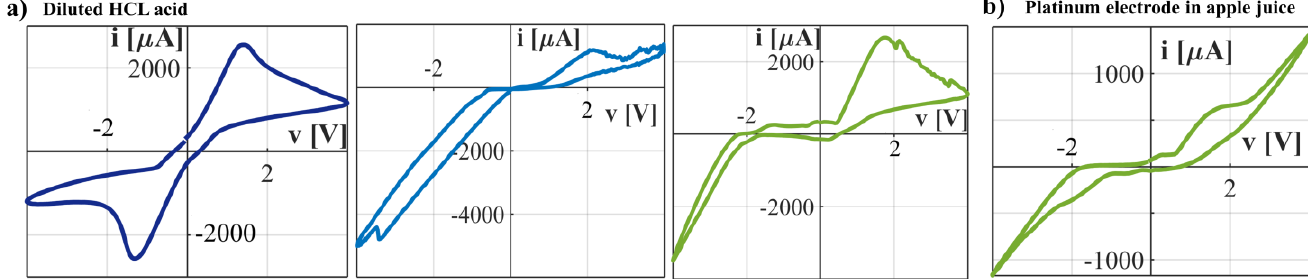
Fig. S3: Additional voltage current plots, always shown for the second period of each measurement. These extra measurements were done in December 2019 with a sinusoidal voltage with an amplitude of 4 V and a frequency of 0.005 Hz. Results from the silver/silver chloride electrode, the stainless steel electrode and a platinum wire (diameter of 0.4mm and length of 1cm) are presented as dark blue, light blue and green plots, respectively. Parts of the isolation of the stainless steel electrode were scratched which means that the active electrode area was larger than the electrode tip. The measurements were done after each other using only one reading channel with R fb1 =0.56 kΩ. a ) Measurements in HCL acid that was diluted with deionized water. The overall pH-value of the solution was 3. Redox reaction of water is happening on all three electrode types. b ) Measurement with the platinum wire in apple juice from